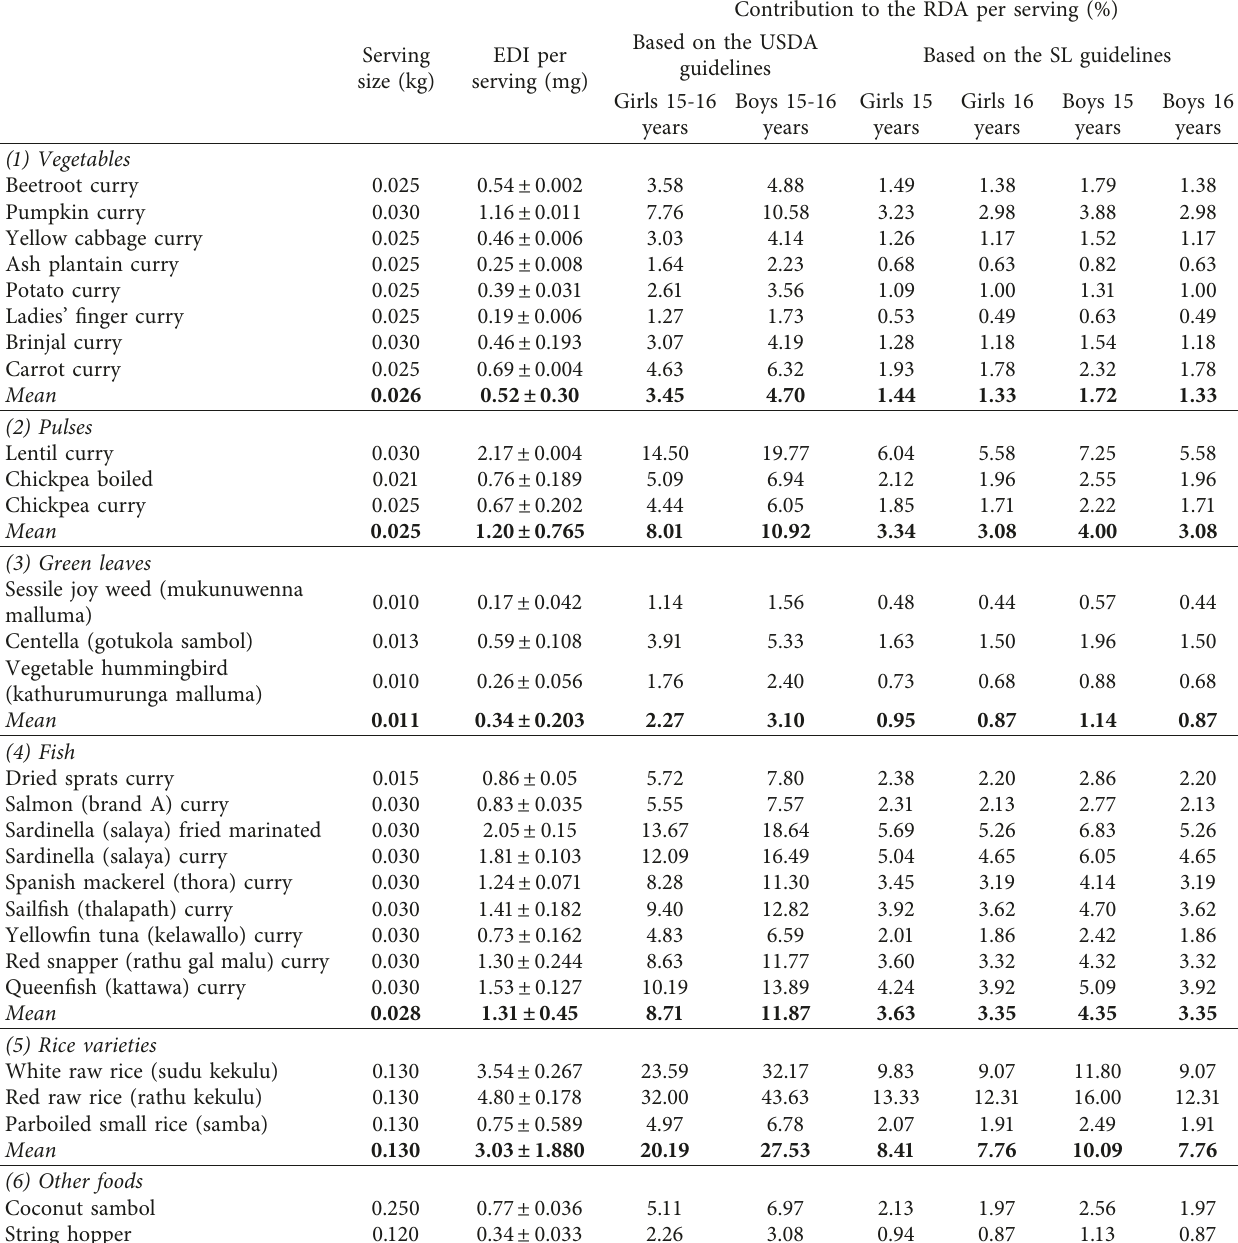
Table 4: Estimated daily intake of iron per serving of each food item and its contribution to RDA. Serving EDI per size (kg) serving